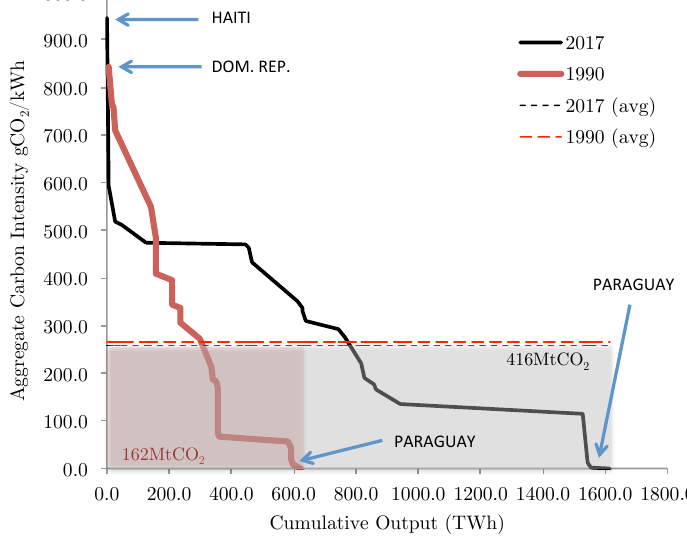
Figure 3. Carbon intensity vs. cumulative electricity production in LAC,